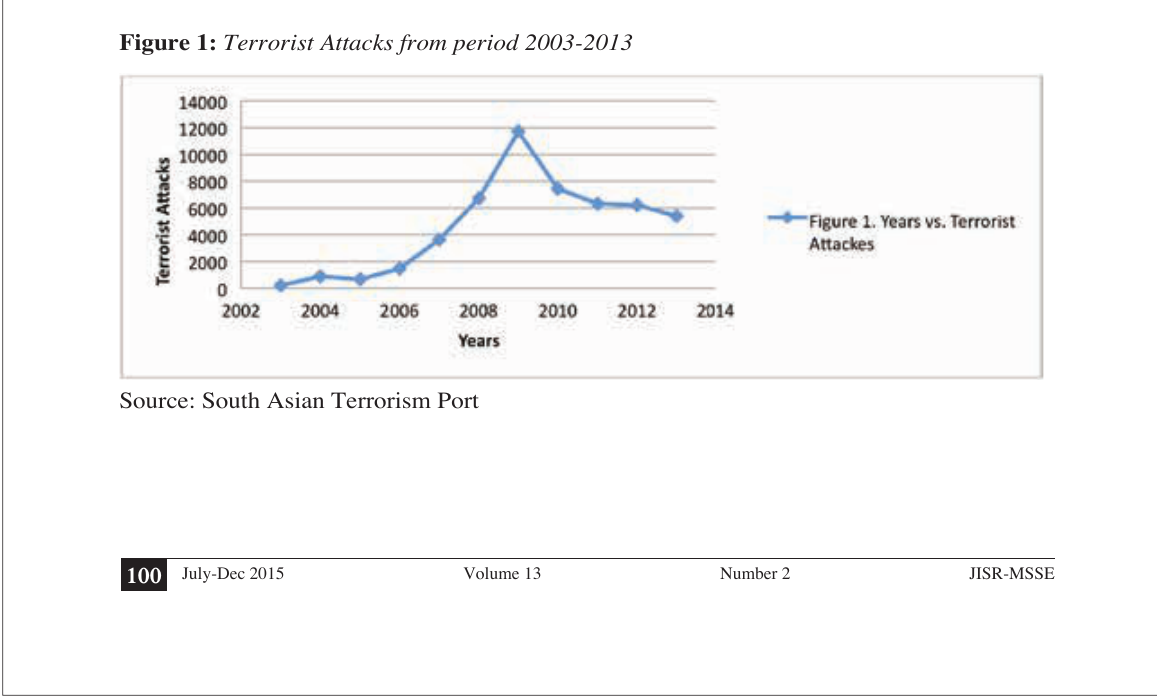
Figure 1: Terrorist Attacks from period 2003-2013